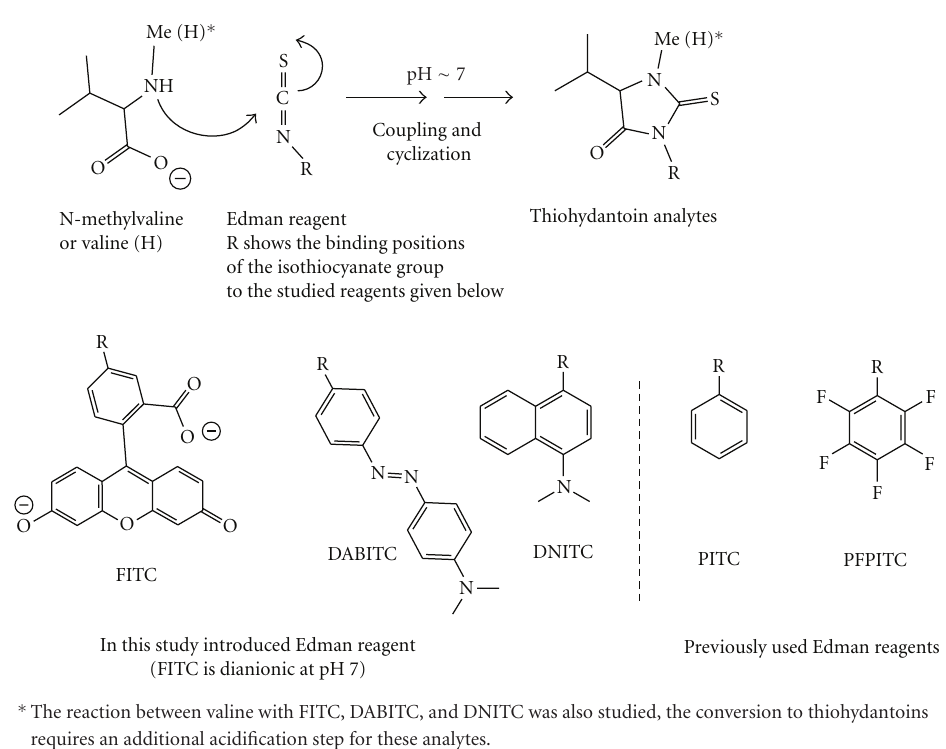
Figure 1: Reactions and Edman reagents compared in this study.